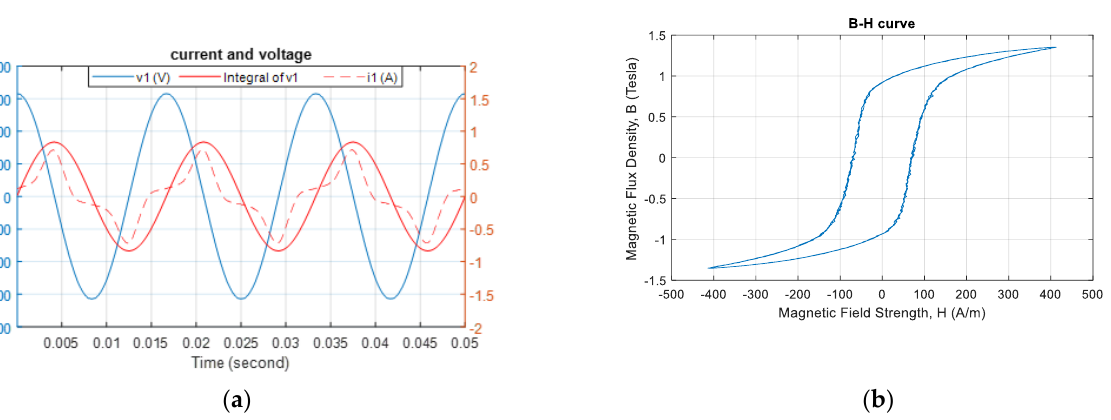
Figure 11. Integration waveform and B – H curve after correcting initial integration position and removing the DC components. ( a ) Normal voltage integration waveform. ( b ) Normal B – H curve.